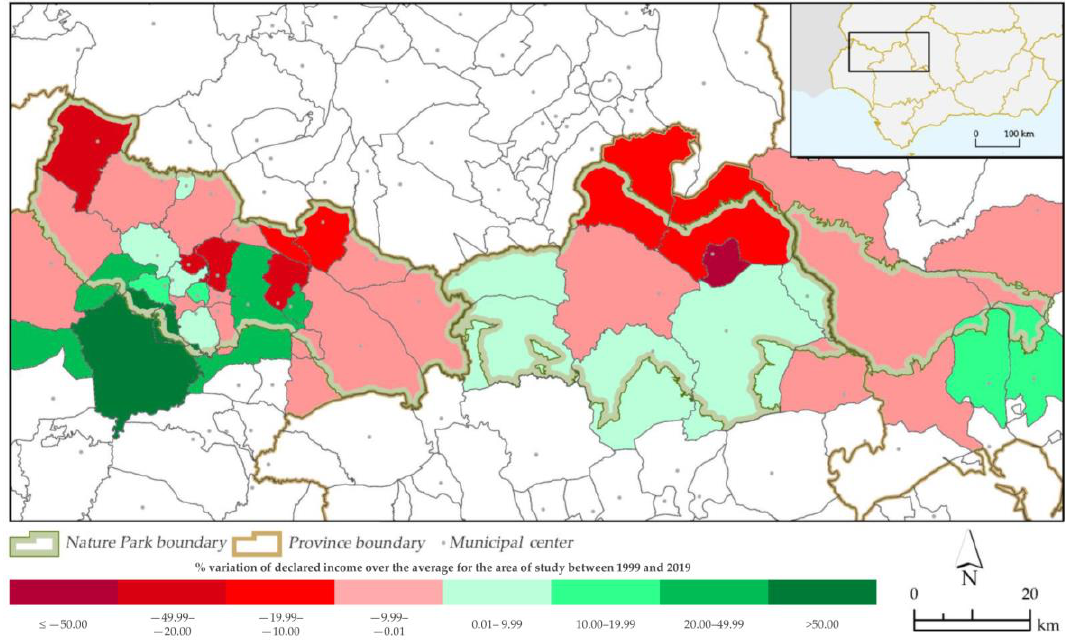
Figure 16. The variation in declared income over the average for the study area between 1989 and 2019 (%). Source: [85]; authors ’ elaboration.